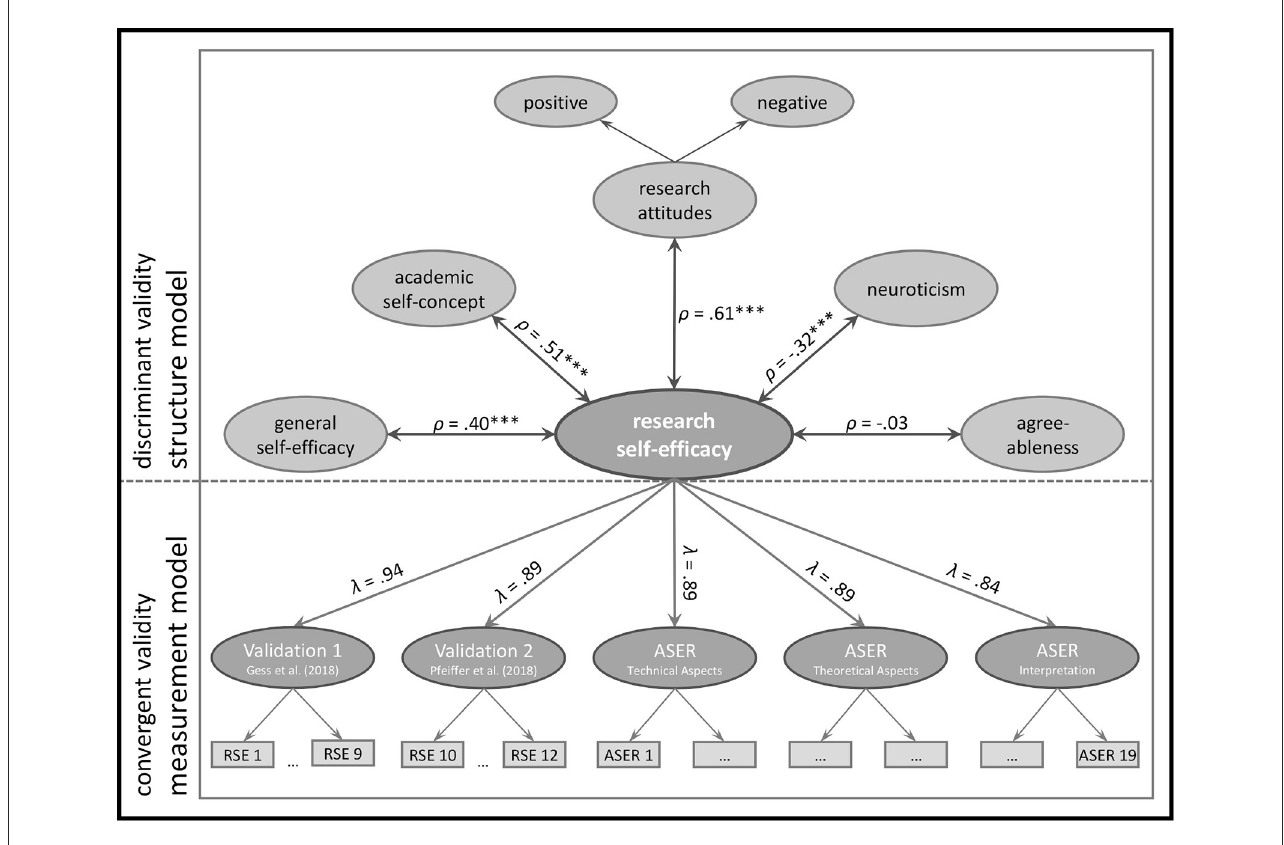
FIGURE1 Conceptual construct validity model with respective parameter